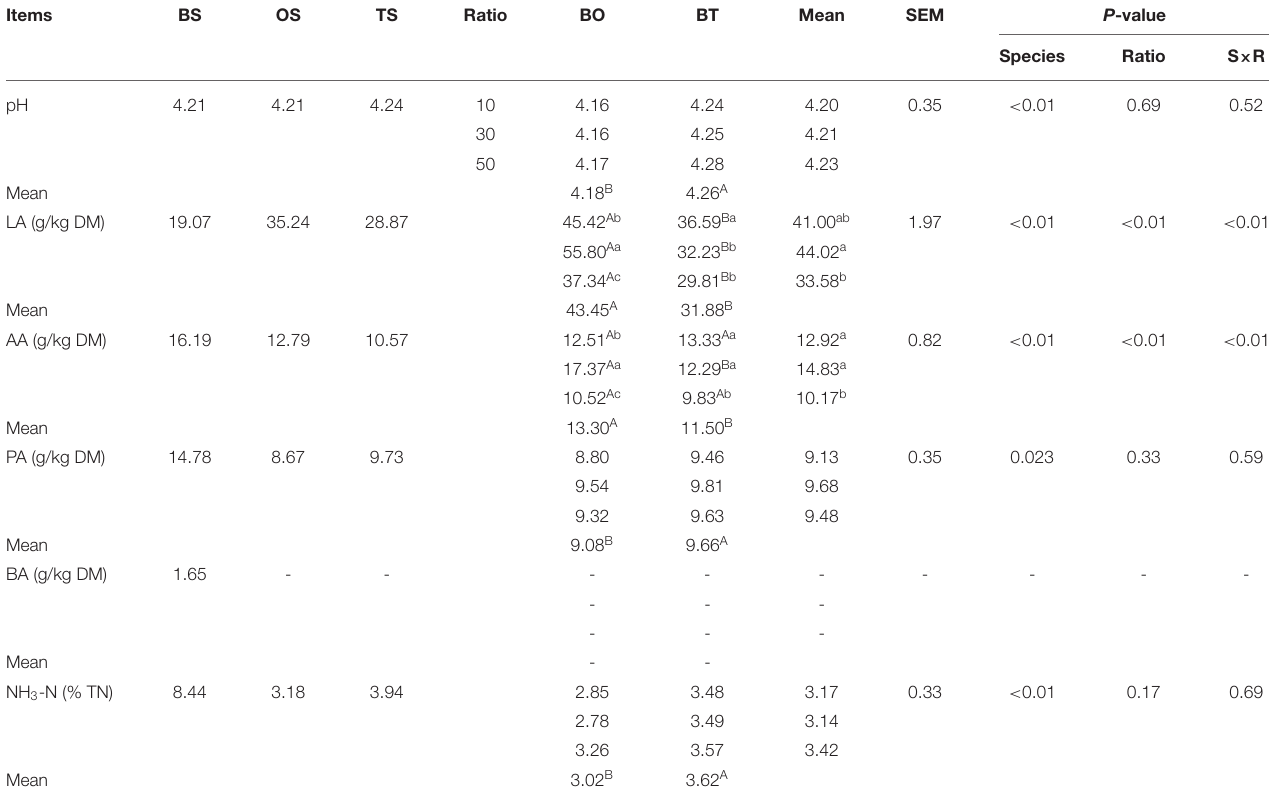
TABLE 3 | Fermentation quality after